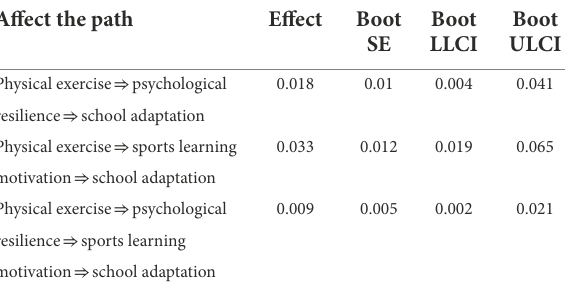
TABLE 6 Bootstrap analysis of mediation effect significance